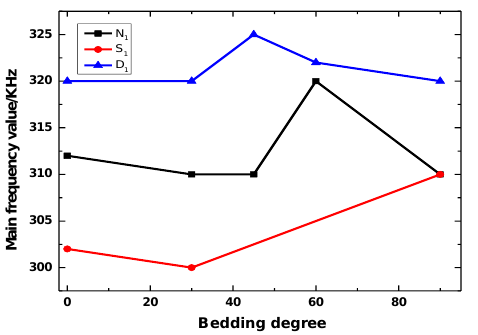
Figure 14. Curves of initial main frequency value with different bedding angles under different water content levels.